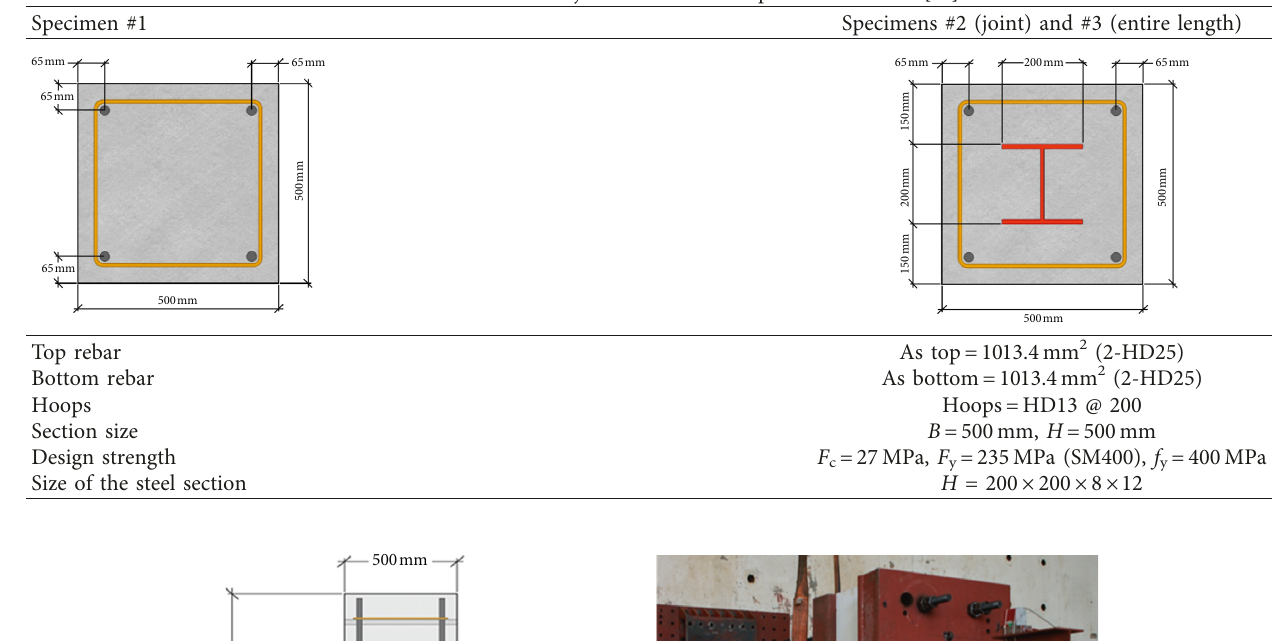
Table 1: Dimensions and joint details of test specimen columns